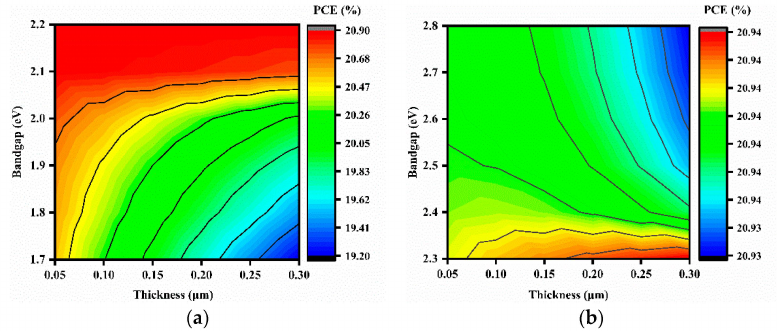
Figure 8. Contour plot between thickness and bandgap for WS 2 ( a ) and IGZO ( b ) ETLs-based